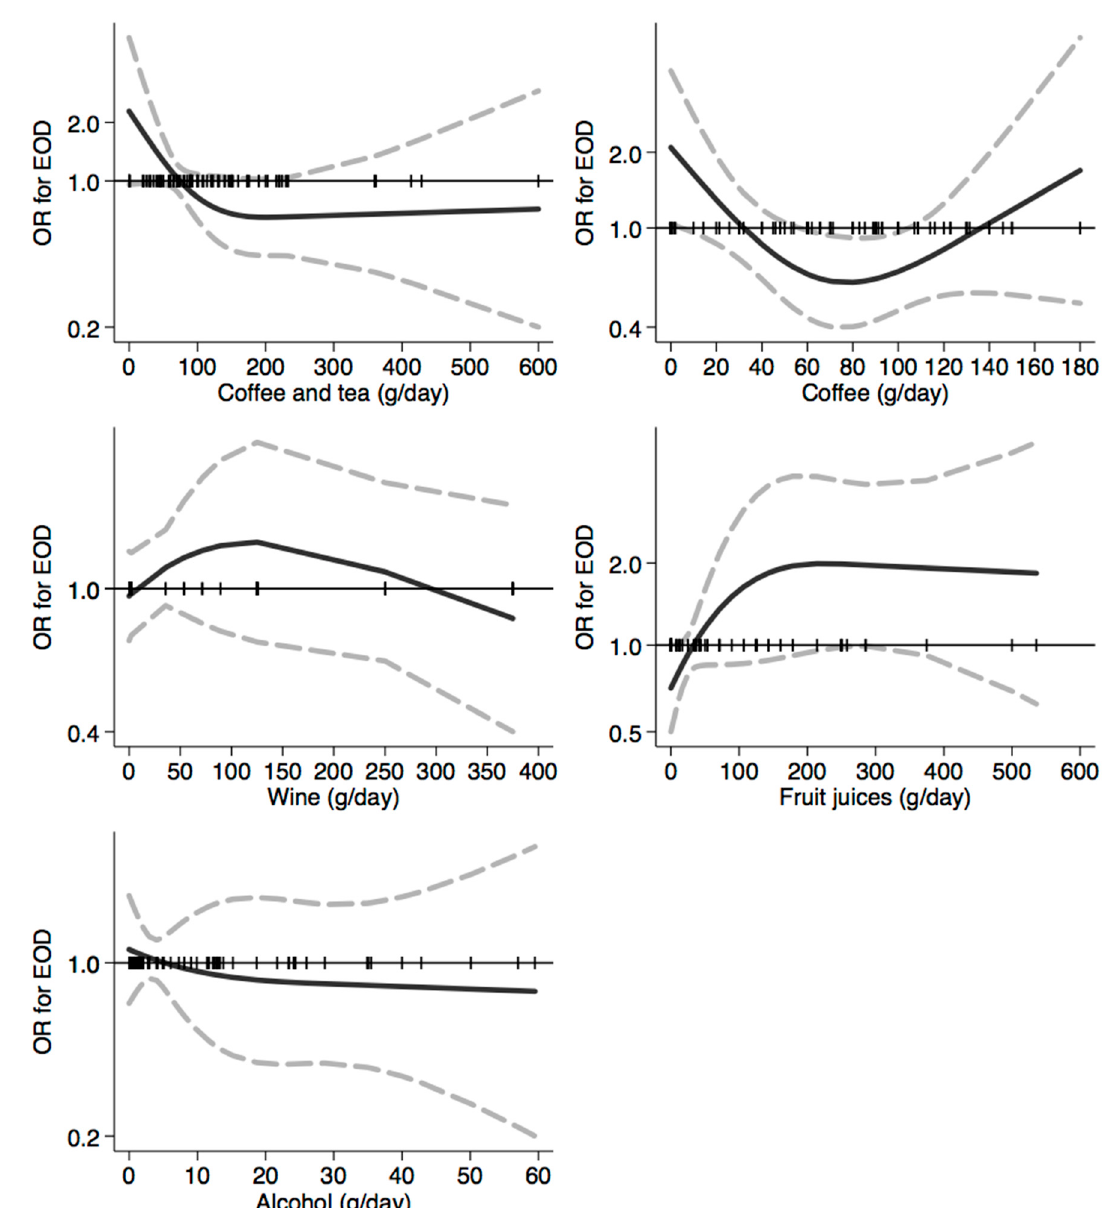
Figure 10. Spline regression analysis of early-onset dementia (EOD) risk for increasing intake of beverages. The black line indicates odds ratios for dementia risk; dash gray lines are 95% confidence limits; the reference line at 1.0 with black spikes indicates the distribution of participant intake. Note: Spline analysis was not possible for most of the beverages (namely tea, red, white and aperitif wines and beers, spirits and soft drinks) due to a few subjects reporting consumption which is different from a null value.